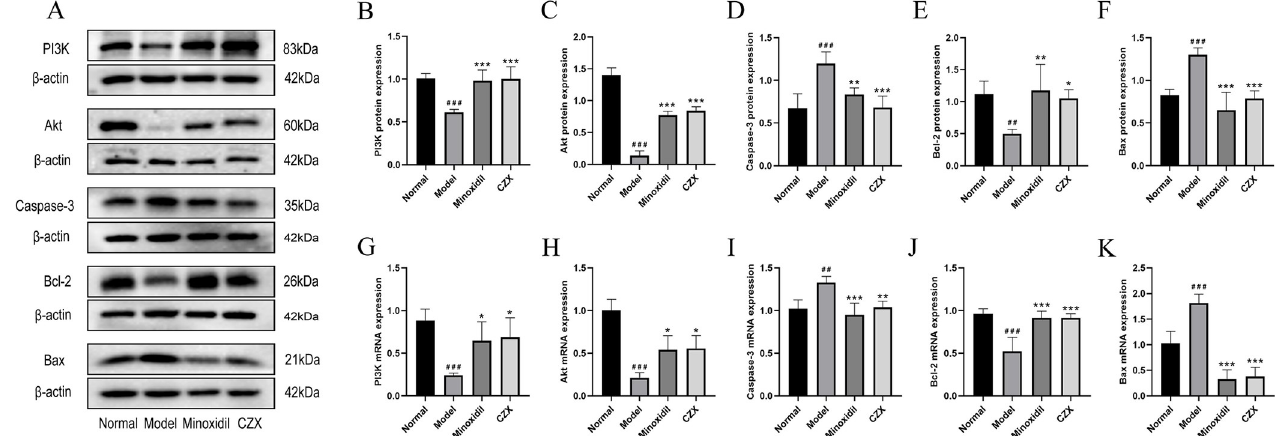
Fig 5. Effect of CZX on the protein and mRNA transcription levels of key genes related to apoptosis and the PI3K/Akt pathway. (A) Representative images of protein expression using Western blotting. Quantification of the protein expression levels of (B) PI3K, (C) Akt, (D) caspase-3, (E) Bcl-2 and (F) Bax from the Western blot analysis. mRNA expression levels of (G) PI3K, (H) Akt, (I) caspase-3, (J) Bcl-2 and (K) Bax from quantitative real-time PCR analysis. The results are presented as the mean ± SD. Compared with the normal group, ## P < 0.01, ### P < 0.001; compared with the model group, � P < 0.05, �� P < 0.01, ��� P < 0.001; n =